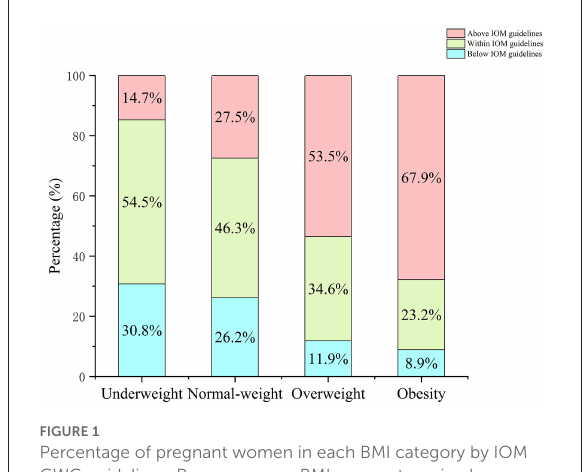
FIGURE1 Percentage of pregnant women in each BMI category by IOM GWG guidelines. Pre-pregnancy BMI were categorized according to Chinese BMI classification (underweight, < 18.5 kg/m 2 ; normal weight, 18.5–23.9 kg/m 2 ; overweight, 24.0–27.9 kg/m 2 ; and obesity, ≥ 28.0 kg/m 2 ).